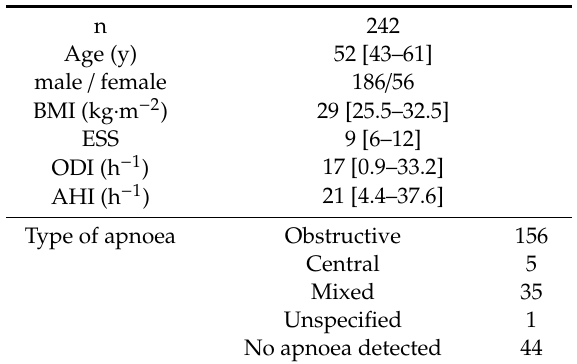
Table 1. Baseline characteristics of patients with suspected sleep apnoea.